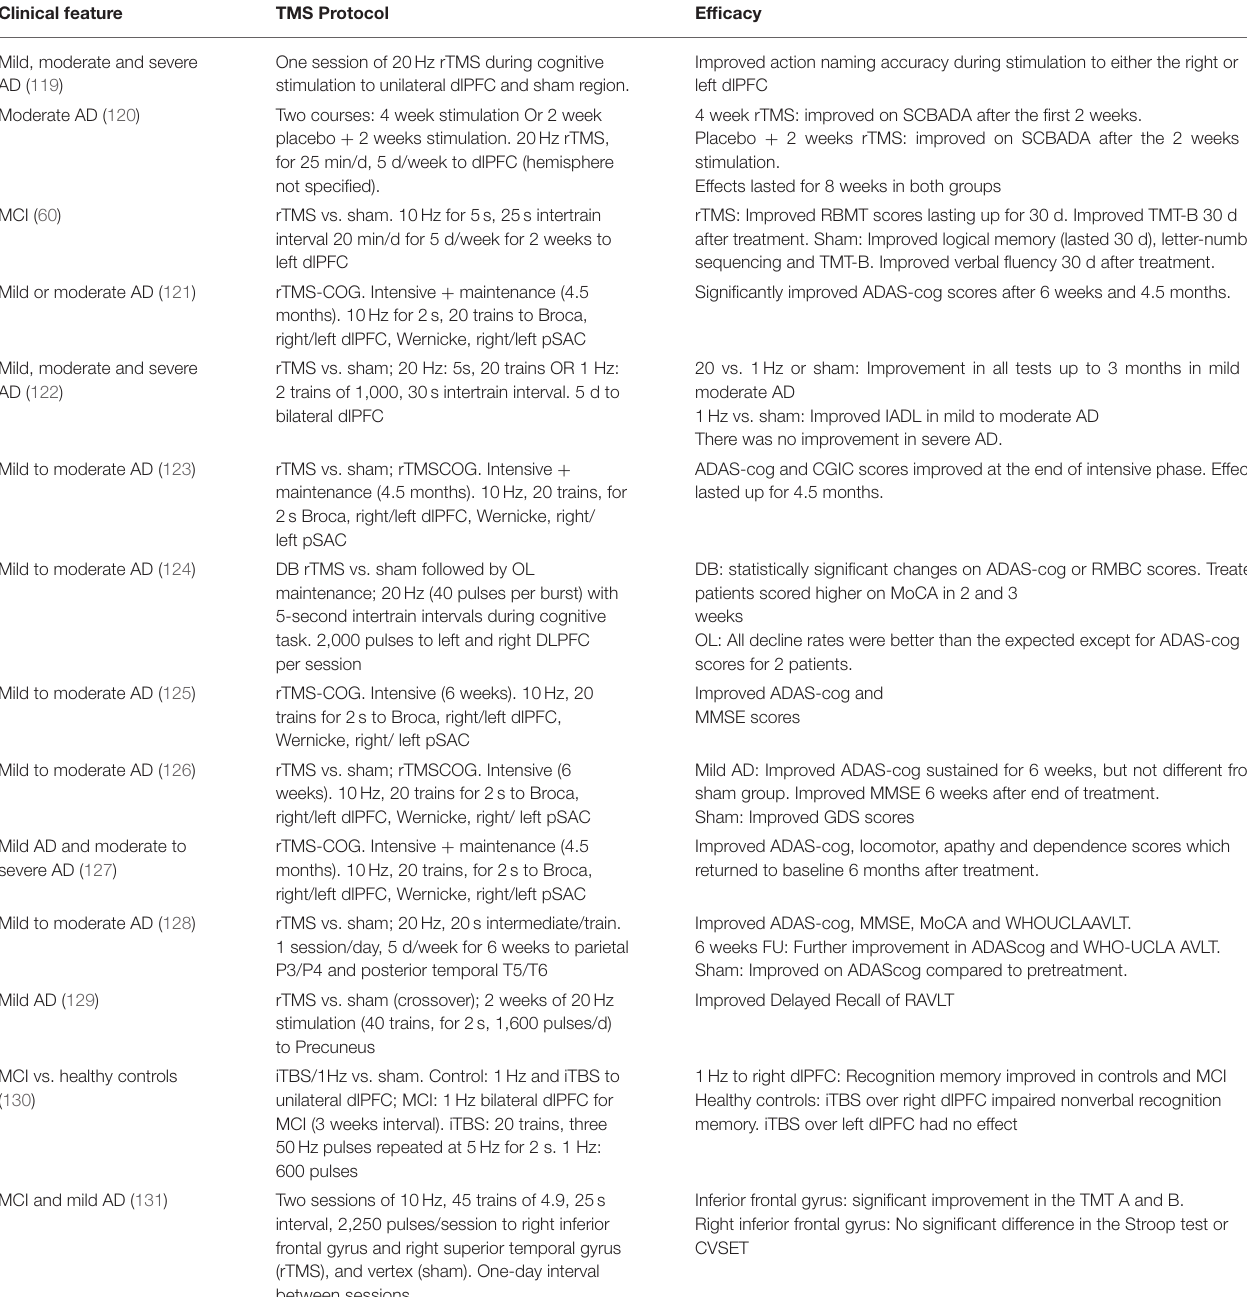
TABLE 4 | TMS in Alzheimer’s disease. Clinical